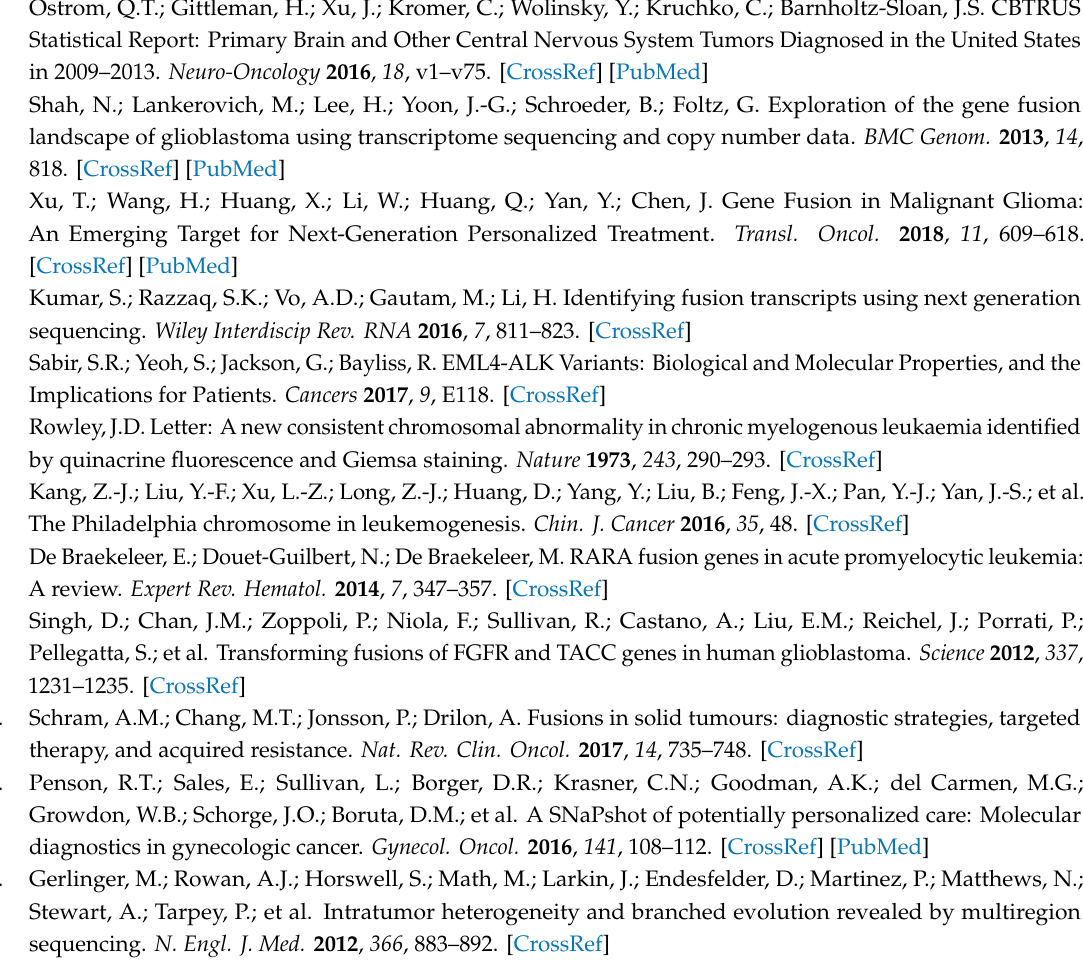
Table S2: Genes screened by QIAseq Targeted RNAscan Panel; Table S3: tumor RNA and EV RNA profiles; Table S4: Summary of fusion calling results; Table S5: Primers design for fusion transcript droplet digital PCR validation; Table S6: Overview of GeneGlobe RNA-seq mapping